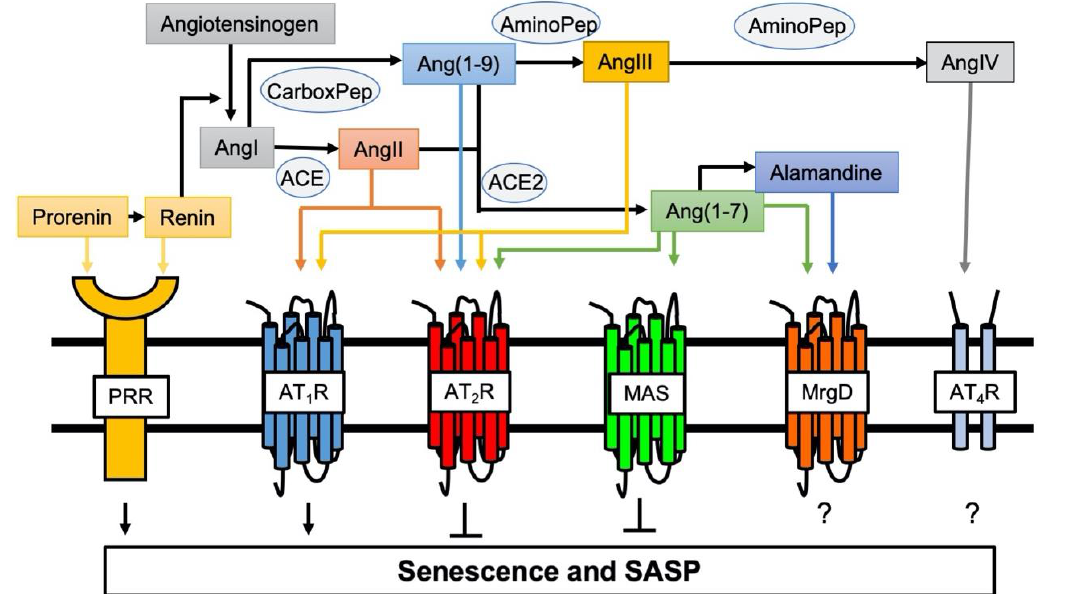
Figure 1. Involvement of novel RAS peptides and receptors in senescence regulation. Classical RAS via activation of AT 1 R positively regulates induction of senescence [55,56]. In contrast, AT 2 R protects against AT 1 R-mediated senescence [50]. Pro (renin) receptor (PRR) is a new member of the RAS receptors and mediates senescence [51]. ACE2 cleaves AngII and Ang(1 – 9) to produce Ang(1-7) to initiate protective arm of novel RAS (the ACE2/Ang(1-7)/MAS axis), which counter-regulates AT 1 R-mediated senescence [52,53]. The roles of additional Ang(1-7) receptor MrgD and AngIV receptor (AT 4 R) play in senescence remain unknown.